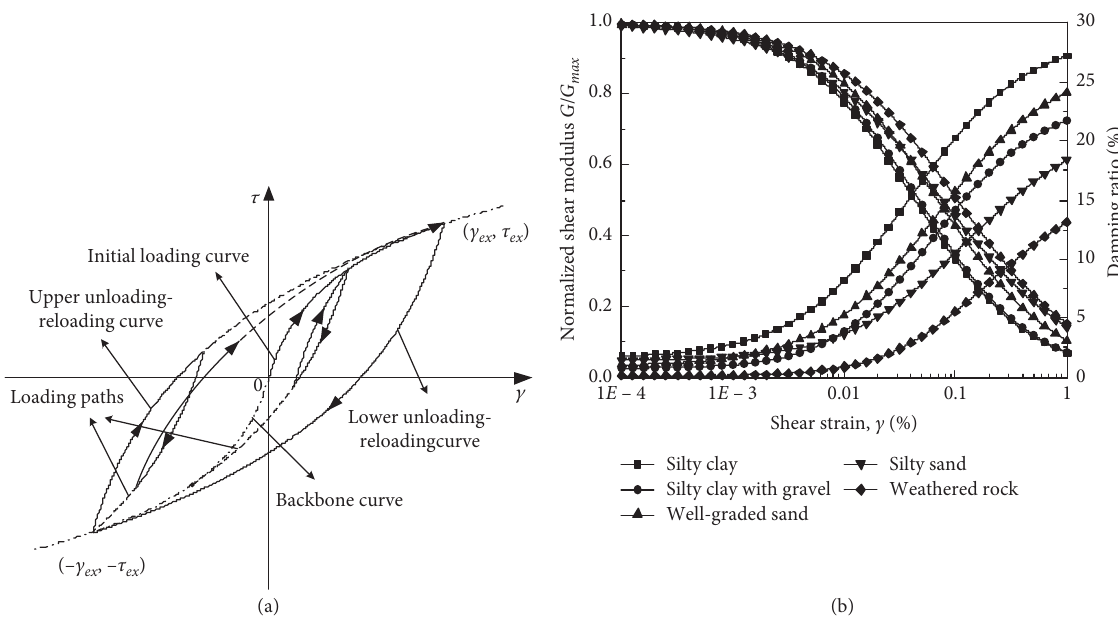
Figure 5: The modified Davidenkov model: (a) stress-strain hysteretic curve; (b) (G)/(G)